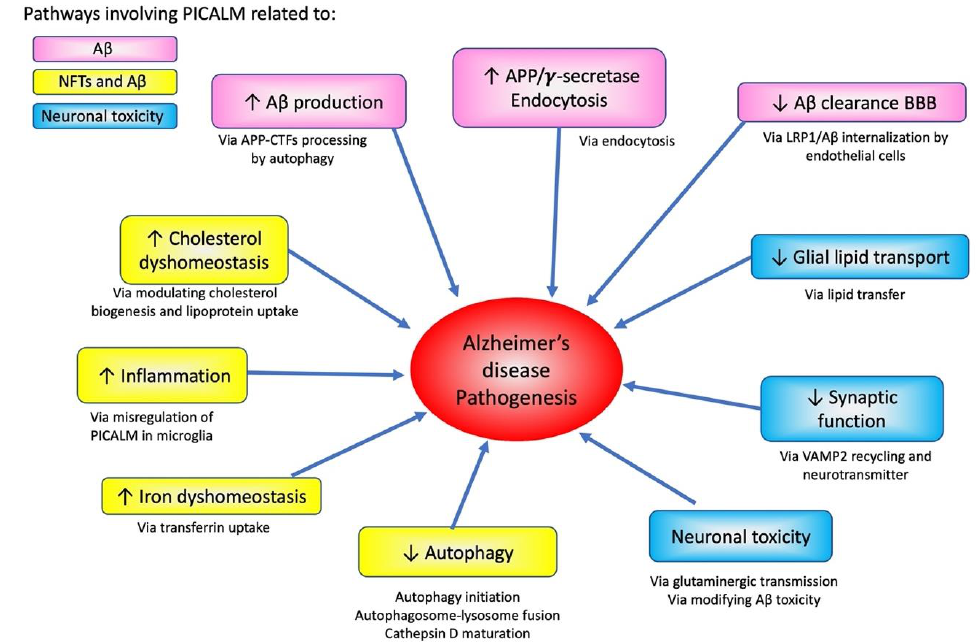
Figure 7. Effects of PICALM on AD pathogenesis pathways and neurodegeneration. PICALM is involved in multiple pathways of AD pathogenesis. PICALM regulates pathways related to APP processing and A β -related neurodegeneration (shown in pink). PICALM plays critical role related to both tau and A β pathologies, such as cholesterol dyshomeostasis, inflammation, iron dyshomeostasis and autophagy (yellow). PICALM is also crucial for neuronal toxicity via glial lipid transport, synaptic functions, glutaminergic transmission and modifying A β -toxicity